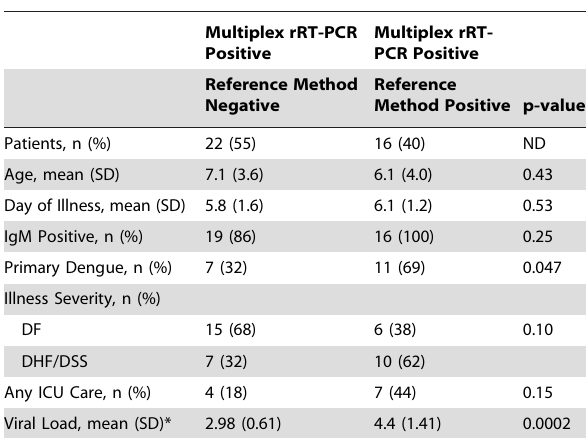
Table 6. Comparison of patients from Sri Lanka that tested positive only by the multiplex rRT-PCR and those that tested positive by both the multiplex rRT-PCR and reference